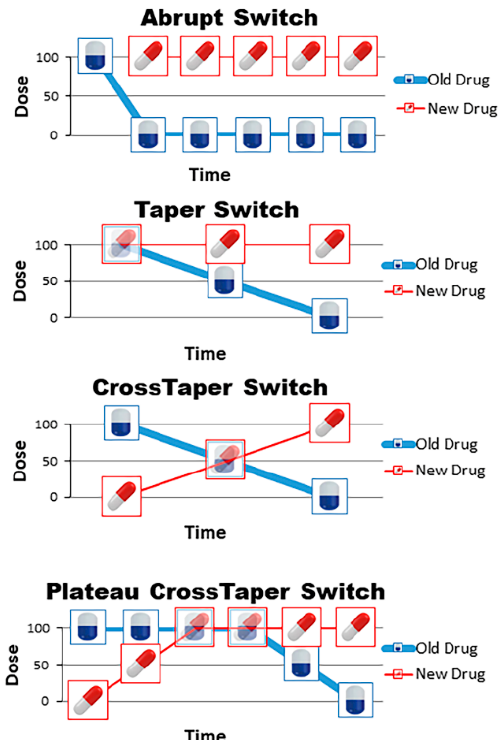
Figure 1. Potential drug-switching schemes. In each panel the old drug is blue, the new drug is red. The x axis represents the timeline and the y axis the percentage of the target dose. The abrupt switch consists of the immediate interruption of the old drug, starting the new drug at full dose. In the taper switch, the old drug is gradually reduced while the new drug is started at full dose. Cross-taper switch consists of gradual reduction of the old drug with gradual increase of the new drug, without overlapping the full doses. Plateau cross-taper switch consists of gradual increase of the new drug, a short overlapping of the two drugs at full dose and then gradual reduction of the old